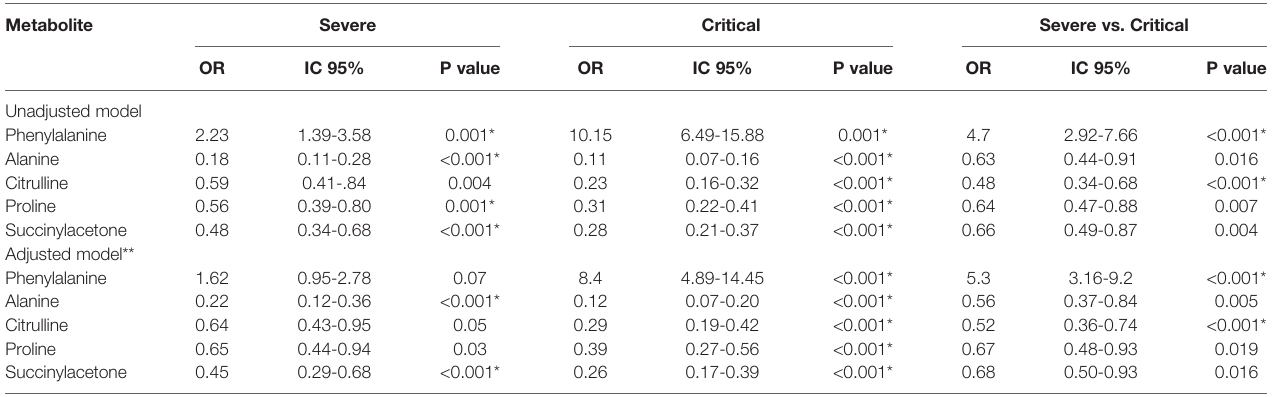
TABLE 2 | Unadjusted and adjusted logistic regression models for the association of metabolite pro fi le with COVID-19 disease severity. Metabolite